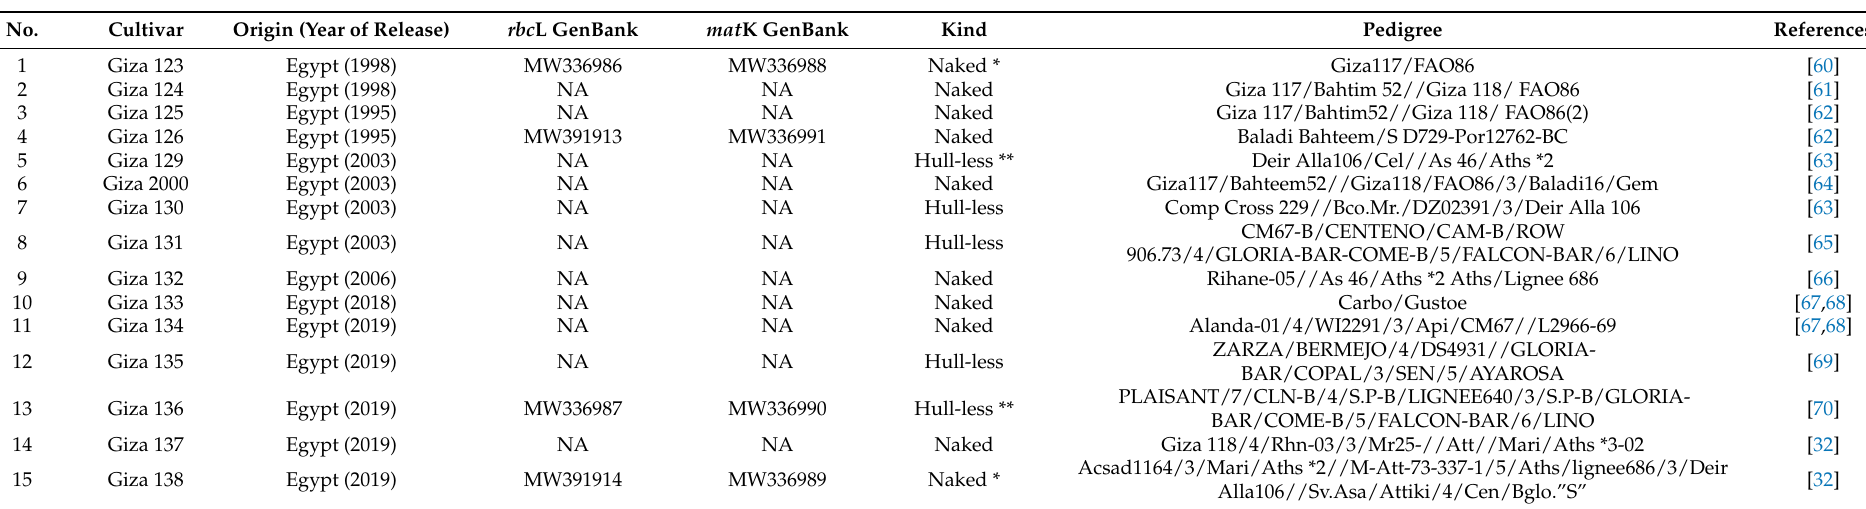
NA: not available; *: has a tough, inedible outer hull around the barley kernel; **: hull-less—the sticks and sprouts separate from the bean when ripe, and the chromosome number is 2n = 2 × = 14 (map view: “barley genome at ncbi.nlm.nih.gov”; retrieved 6 October